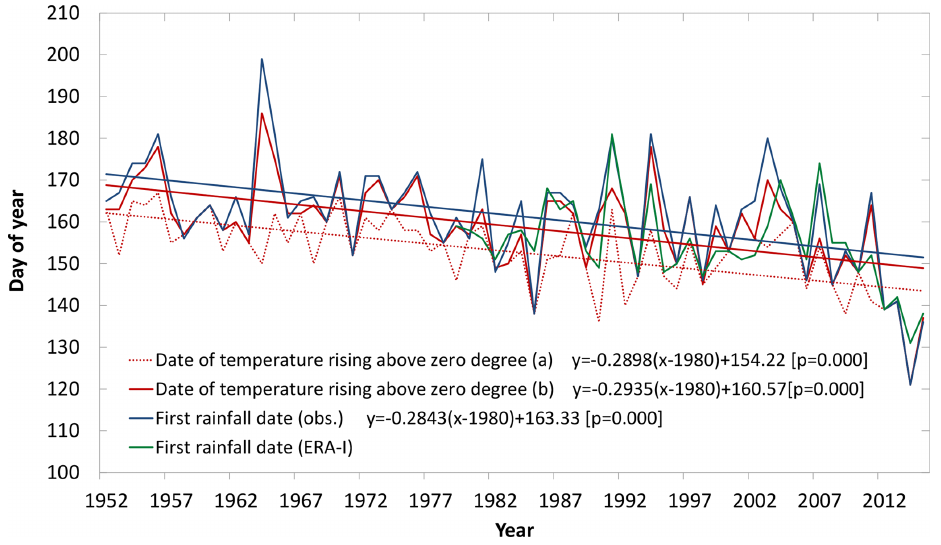
Figure 7. Timing of air temperature exceeding 0 ◦ for the first time and the timing of first rainfall in spring at the WSO AP site, 1952–2015. The dashed red line (a) corresponds to the first instance of air temperature above 0 ◦ C. The solid red line (b) indicates the first warming event continuing for at least 4 days. p denotes the significance value of the linear trend.